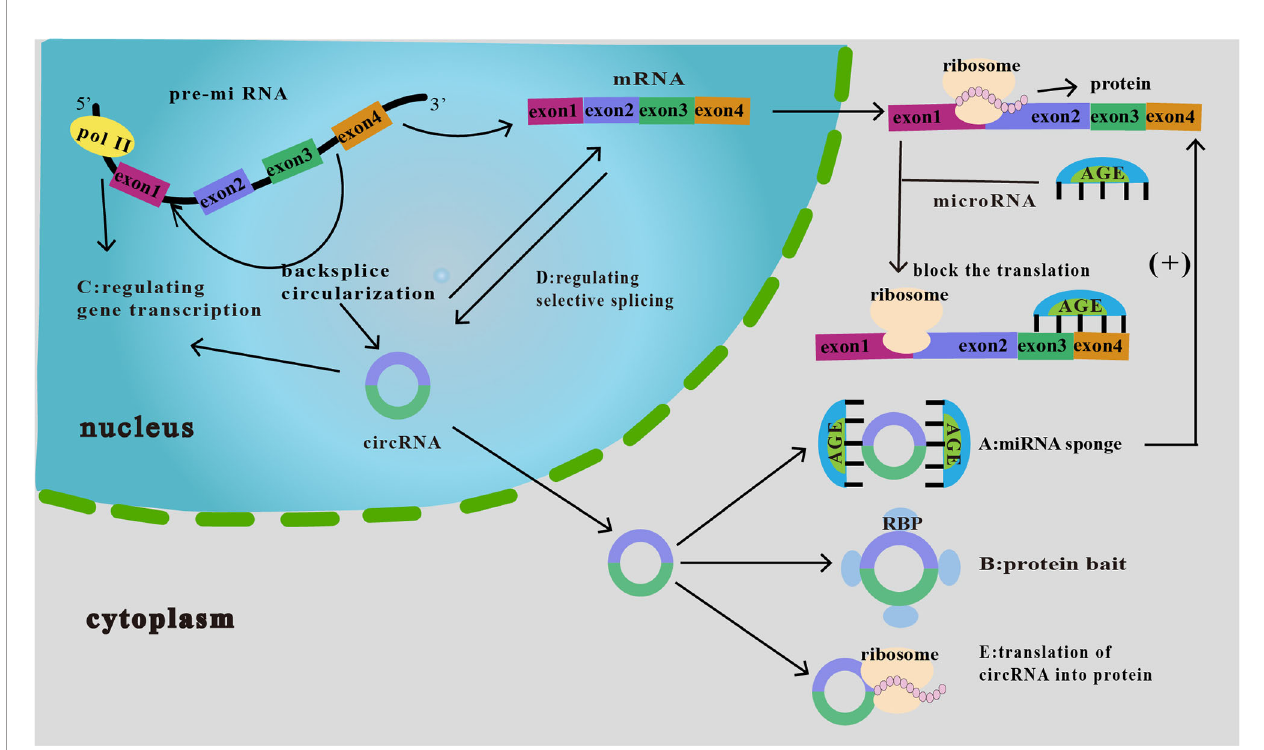
FIGURE 2 | Functions of circRNAs. (A) As miRNA sponge. CircRNA binds miRNAs and inhibits their downstream responses, which then increases the expression of downstream target proteins, thereby affecting tumor proliferation, invasion, and migration. (B) As protein bait. CircRNAs act as protein decoys or antagonists to inhibit protein function, thus affecting the related progression of cancer. (C) Regulation of gene transcription. CircRNA interacts with RNA polymerase II to regulate the transcription and expression of parental genes. (D) Regulation of selective splicing. CircRNAs compete with linear RNAs; if the formation of circRNAs increases, linear splicing decreases. (E) Translation of circRNA into protein. CircRNAs can be translated into proteins in an unusual cap-independent